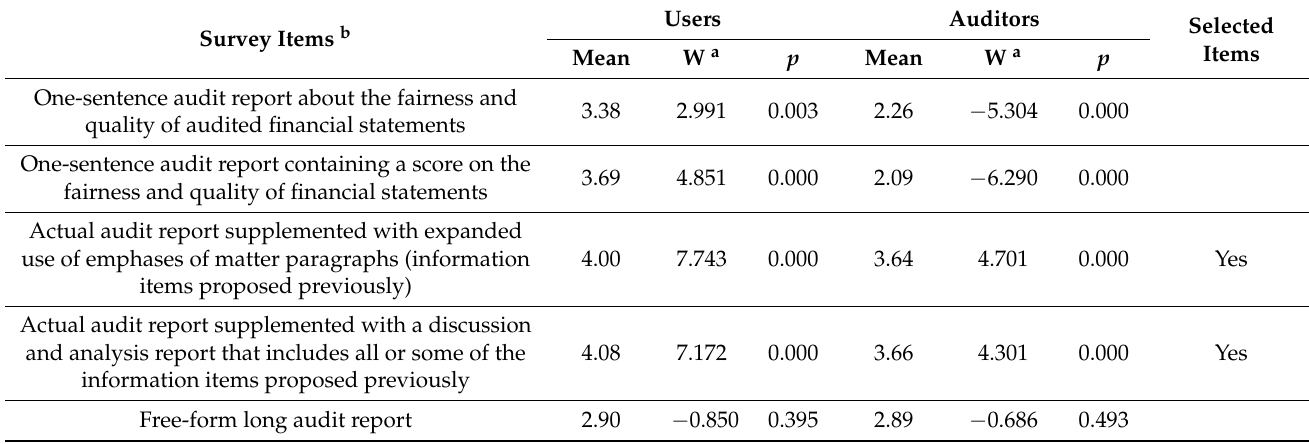
Table 7. Perceptions of format of audit reports to enhance their